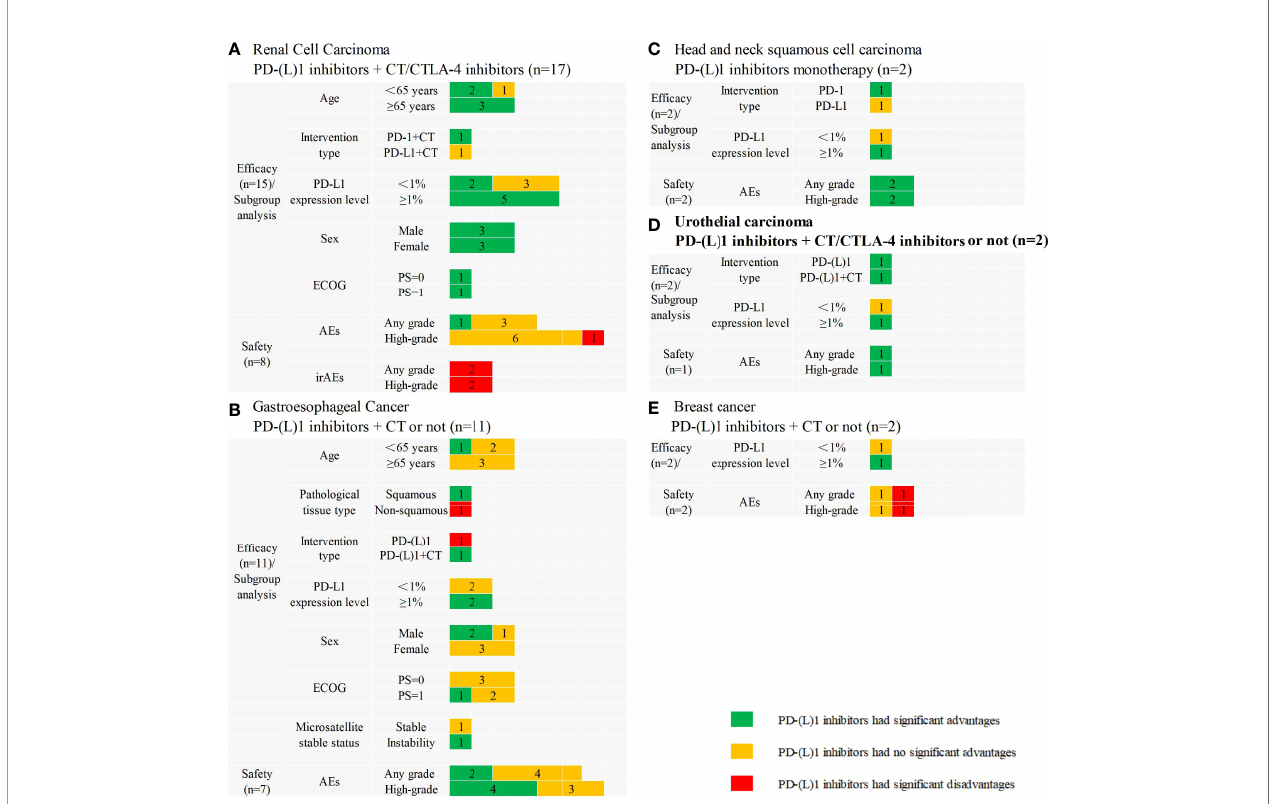
FIGURE 3 | Subgroup analyses and safety results in other cancers. (A) PD-(L)1 inhibitors plus chemotherapy/cytotoxic T lymphocyte associated antigen 4 pathway inhibitors versus chemotherapy in renal cell carcinoma; (B) PD-(L)1 inhibitors plus chemotherapy or not versus chemotherapy in gastroesophageal cancer; (C) PD-(L) 1 inhibitors monotherapy versus chemotherapy in head and neck squamous cell carcinoma; (D) PD-(L)1 inhibitors plus chemotherapy/cytotoxic T lymphocyte associated antigen 4 pathway inhibitors or not versus chemotherapy in urothelial carcinoma; (E) PD-(L)1 inhibitors plus chemotherapy or not versus chemotherapy in breast cancer. CT, chemotherapy; CTLA-4, cytotoxic T lymphocyte associated antigen 4; n, the number of included systematic reviews; ECOG, Eastern Cooperative Oncology Group; PS, performance status; AEs, adverse events; irAEs, immune-related adverse events; High-grade, ≥ 3